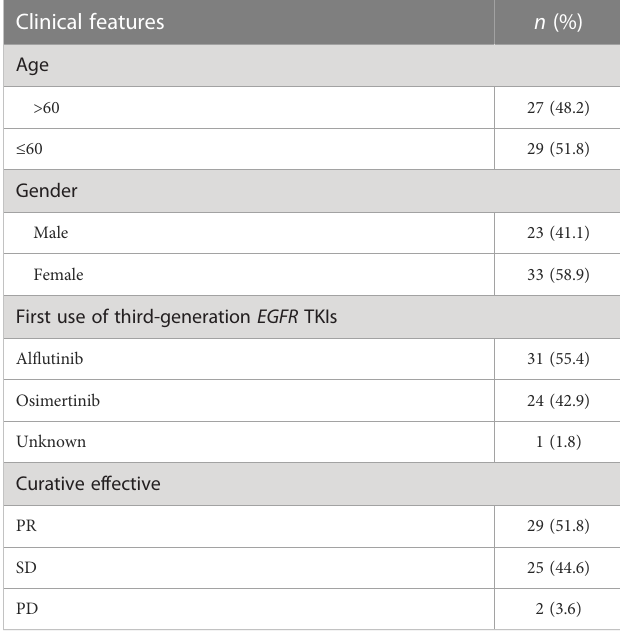
TABLE 4 Clinical features of the 56 patients treated with the third generation of EGFR tyrosine kinase inhibitors (TKIs). Clinical features